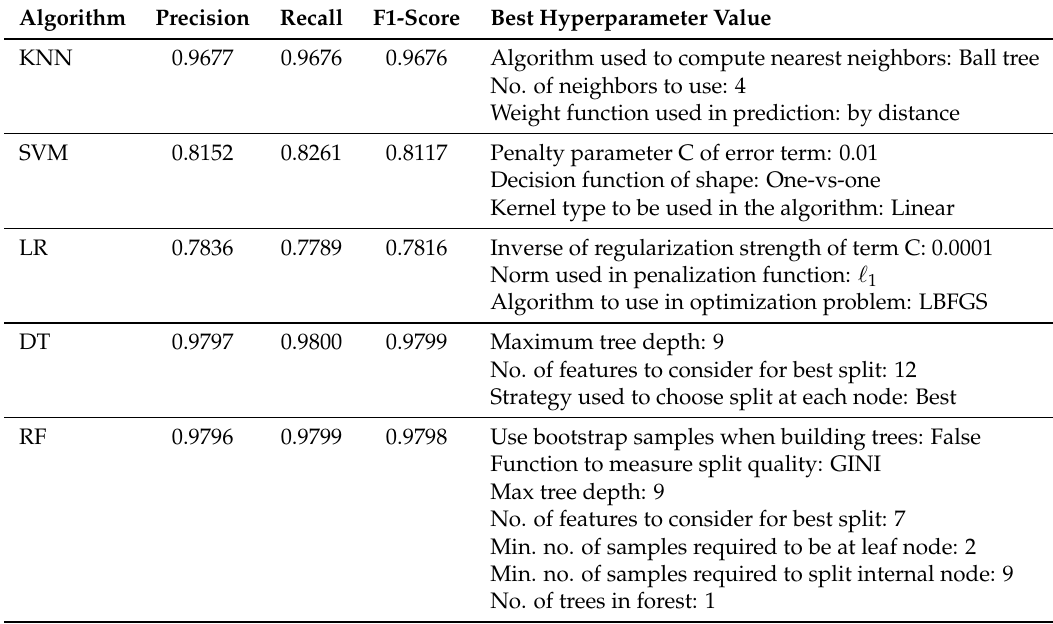
Table 9. ISCX-Bot-2014 (SMOTE + GS) scores.